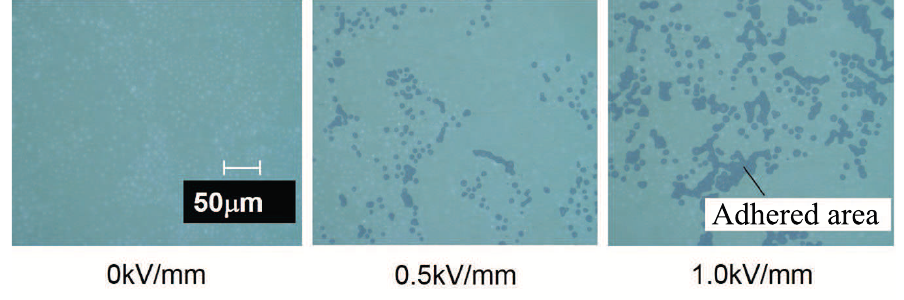
Figure 3. EA phenomenon.